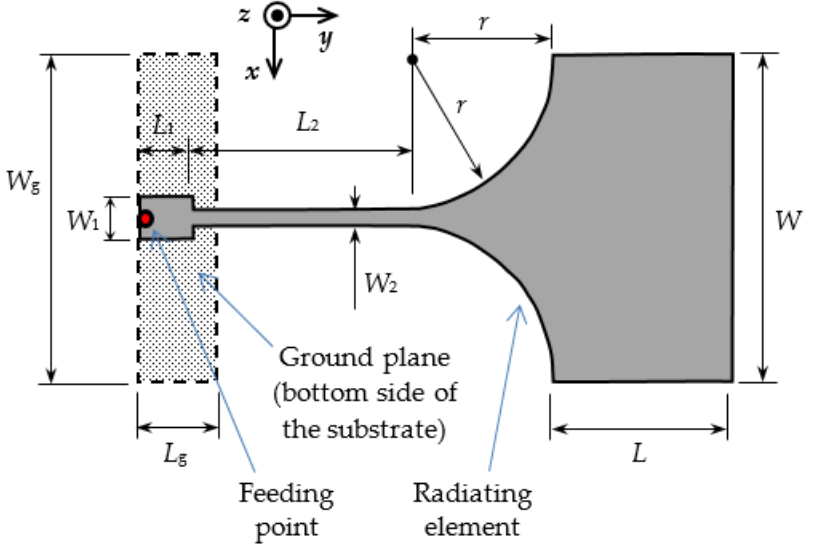
Figure 3. Textile planar wideband monopole; the radiating element is on the top and the ground plane on the bottom side of the textile substrate. The appropriate coordinate system for the radiation patterns is shown on the top middle of the figure.